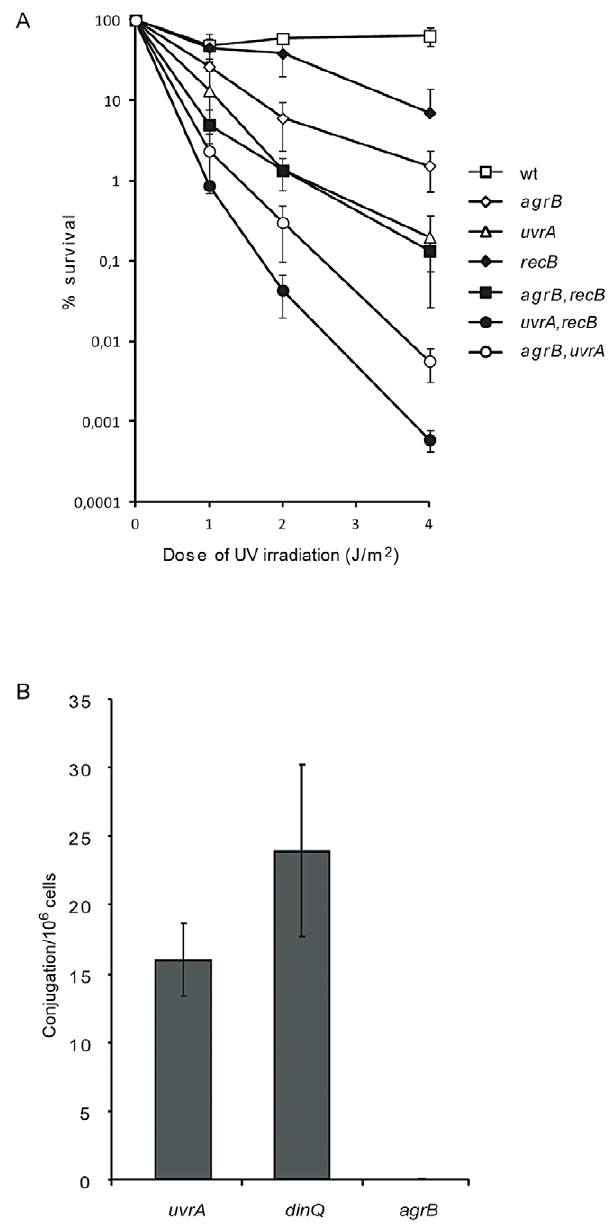
Figure 6. Genetic interactions between agrB and uvrA / recB and recombination frequency of agrB . (A) Dilutions of exponentionally growing wild type (AB1157, open square), agrB (BK4148, open diamond), uvrA (BK4180, open triangle), recB (BK4110, black diamond), agrB recB (BK4112, black square), uvrA recB (BK4183, black circle) and agrB uvrA (BK4182, open circle) cells were plated on LB plates and exposed to UV irradiation. Colonies were counted one day after incubation at 37 u C. The data are presented as mean of three independent experiments with standard deviation. (B) Recombination frequency of uvrA (BK4180), dinQ (BK4040) and agrB (BK4043/BK4148) determined by Hfr conjugation assays. The data are presented as mean of three independent experiments with standard